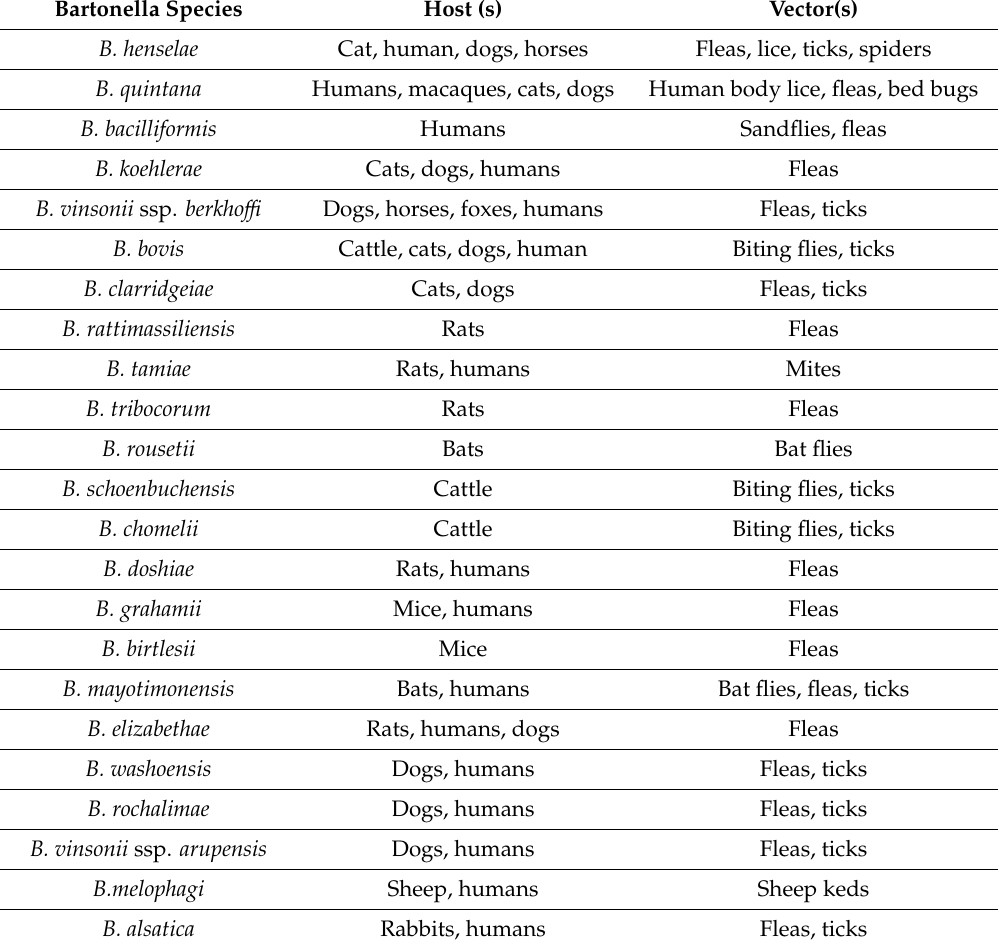
Table 1. The known Bartonella species, their hosts, and their vectors: The table has been adapted from Breitschwerdt, 2017 5